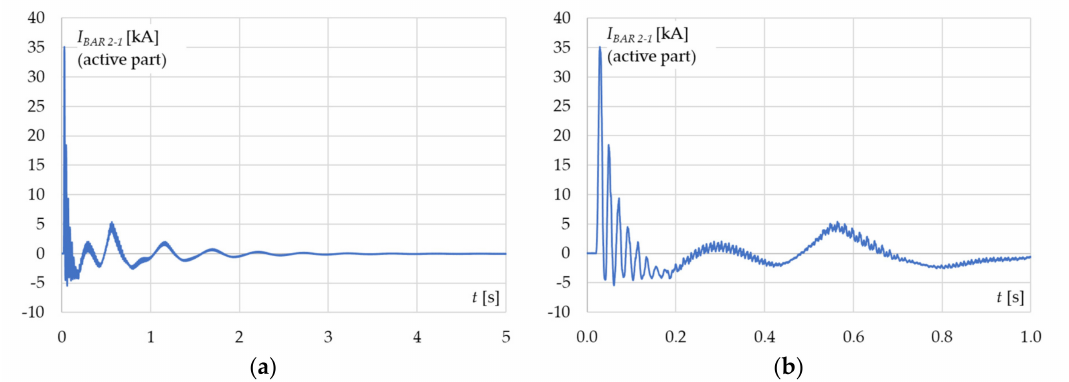
Figure 18. Waveform of induced current in bar No. 2-1 during out-of-phase synchronization of − 120 ◦ in ( a ) the scope of the considered calculation time and ( b ) the first second.